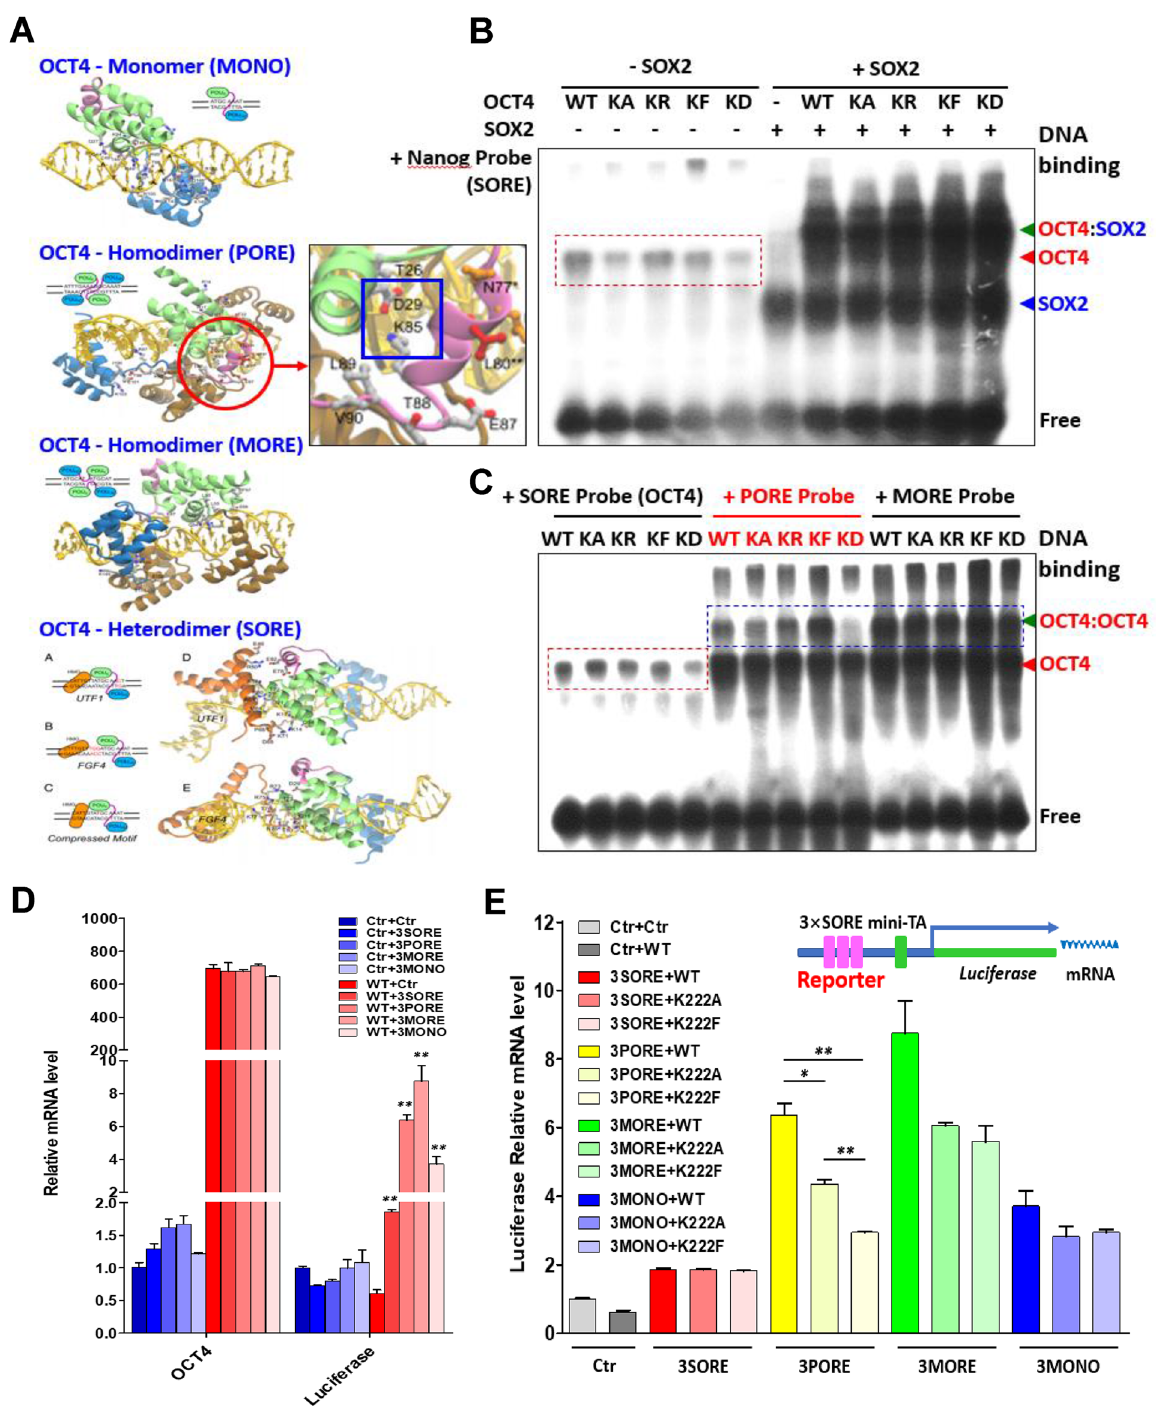
Figure 4. OCT4-K222F promotes the ‘locked-in’ mode engagement of OCT4 PORE-homodimers and represses their transcriptional activities in vitro. ( A ) Models of OCT4 monomer, PORE, MORE homodimer and OCT4/SOX2 heterodimer binding to their specific DNA motifs (pictures adopted from Esch et al., 2013; Jerabek et al., 2014). ( B ) and ( C ) EMSA experiments examining the binding of purified recombinant His-OCT4 (WT and K222 variants) proteins singly or in combination with recombinant SOX2 proteins, to biotinylated SORE, PORE and MORE probes. ( D ) HeLa cells were co-transfected with different OCT4-binding motif-luciferase reporter constructs and the WT OCT4 construct with the empty vector as a control, relative mRNA levels of the expressed OCT4 and luciferase were determined by qRT- PCR 48 h after transfection. ( E ) HeLa cells were co-transfected with different OCT4-binding motif-luciferase reporter constructs and the OCT4 constructs (WT and K222 variants) with the empty vector as a control, the relative luciferase mRNA levels were determined by qRT-PCR 48 h after transfection. Results shown in ( D ) and ( E ) were presented as means ± S.D. of triplicate measurements from single experiment representative of 3 independent experiments. Two- tailed unpaired Student’s t tests were used for statistical analyses. *P < 0.05 and **P <